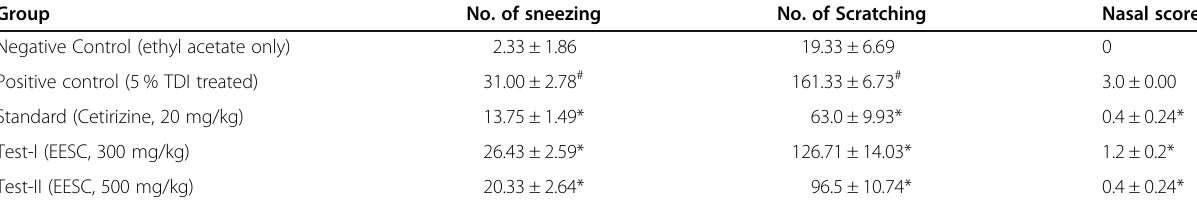
Table 5 Assessment of allergy-like symptoms in mice Group No. of sneezing